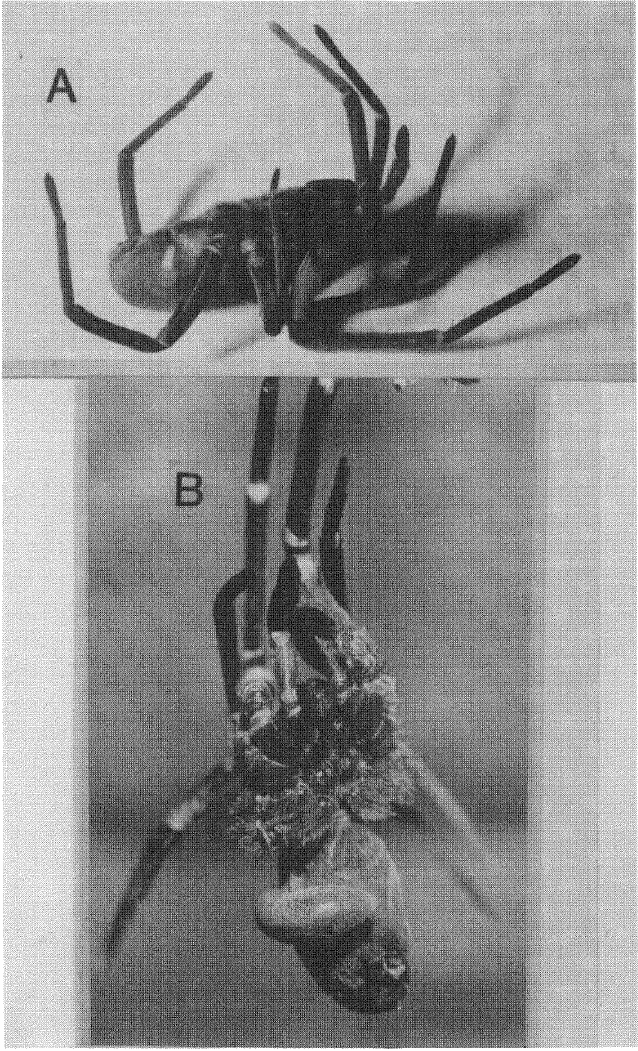
Fig. 3. A, F. hibernalis with egg of A. azureus; B, larva of A. azureus at 3